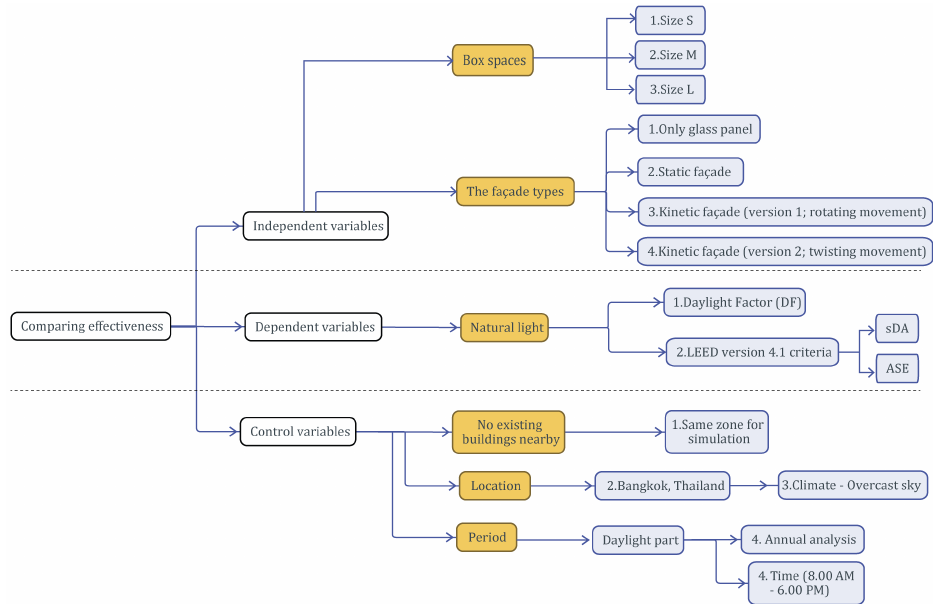
Figure 5. Variant diagram for the comparison of